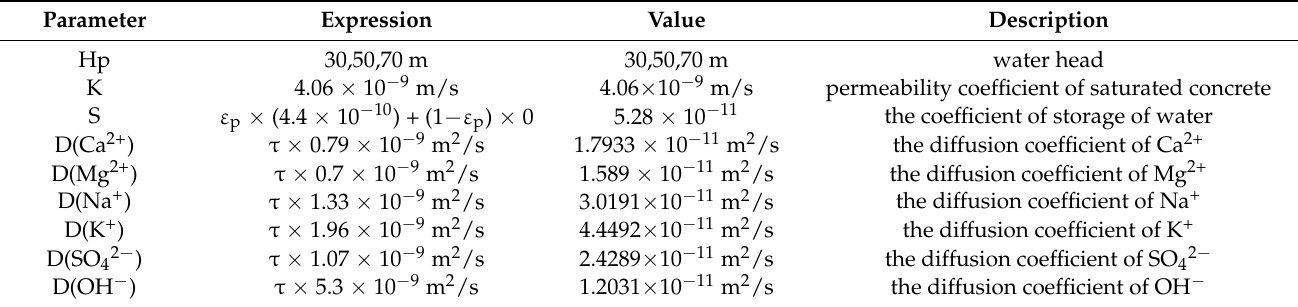
Figure 1. The COMSOL simulation model setup and meshing. Table 2. Key parameters of the model.